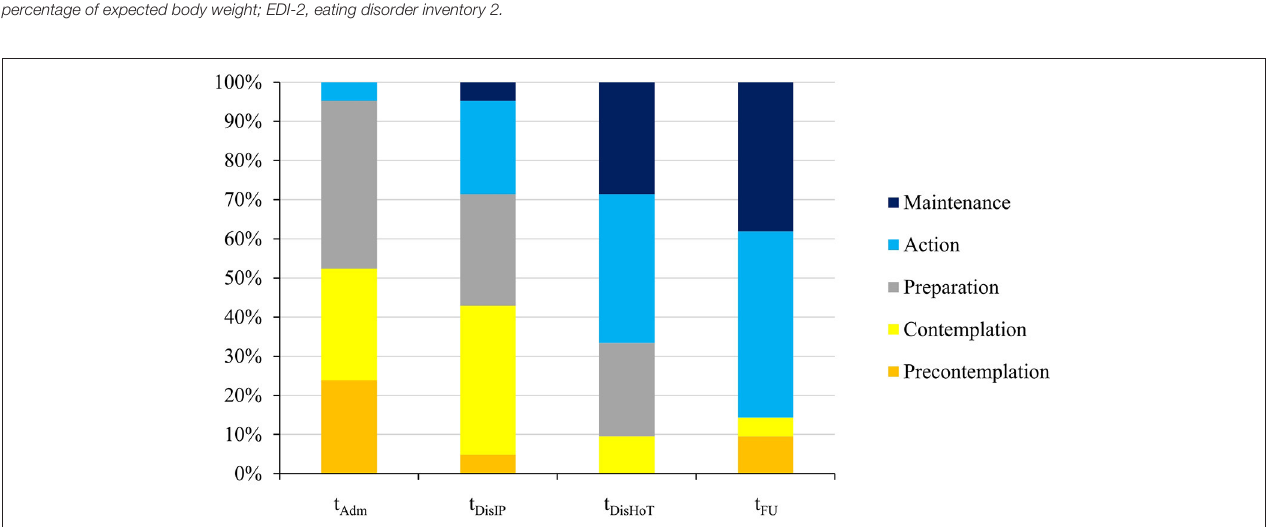
cognitive ED illness severity, with consistently strong correlations between − 0.53 and − 0.77 (see Table 3 ). The relationship between the physical index of illness severity (%EBW) and motivation to change was generally less pronounced (Spearman ρ s: − 0.21 to − 0.39) and was not significant in our rather small sample. At admission, patients with higher relative body weight tended to have lower motivation, while this trend was reversed at the follow-up (see Table 2 ). The duration of illness and the participants’ age were not significantly associated with the ANSCOQ sum score at admission in this